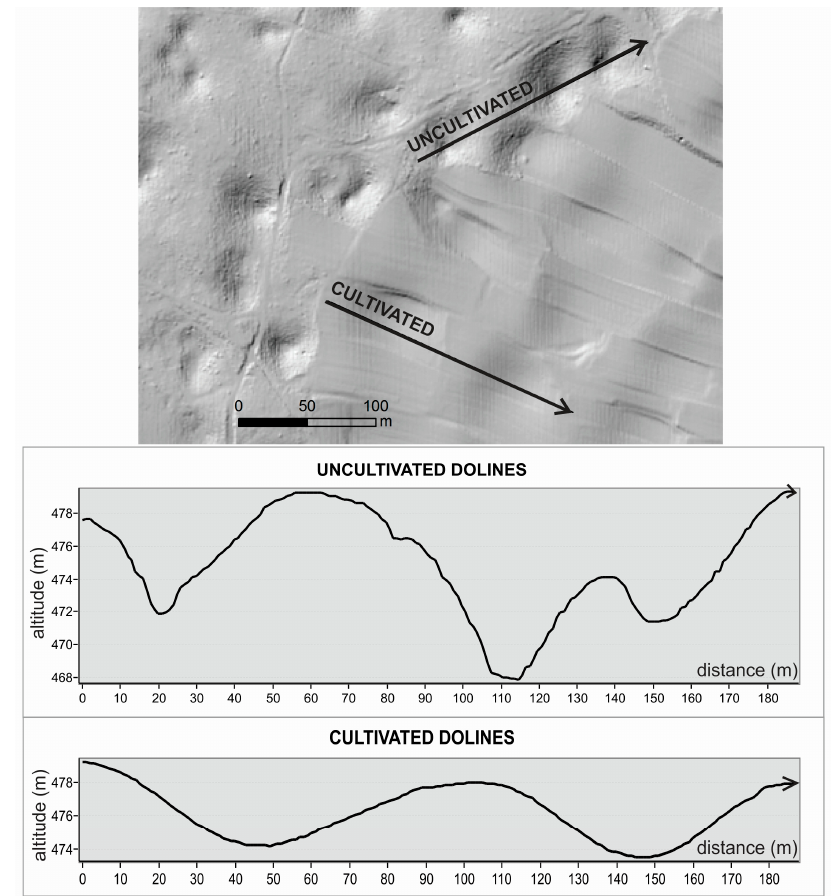
Figure 3. Topographic profiles across cultivated and uncultivated dolines at Poljšica field site [37].